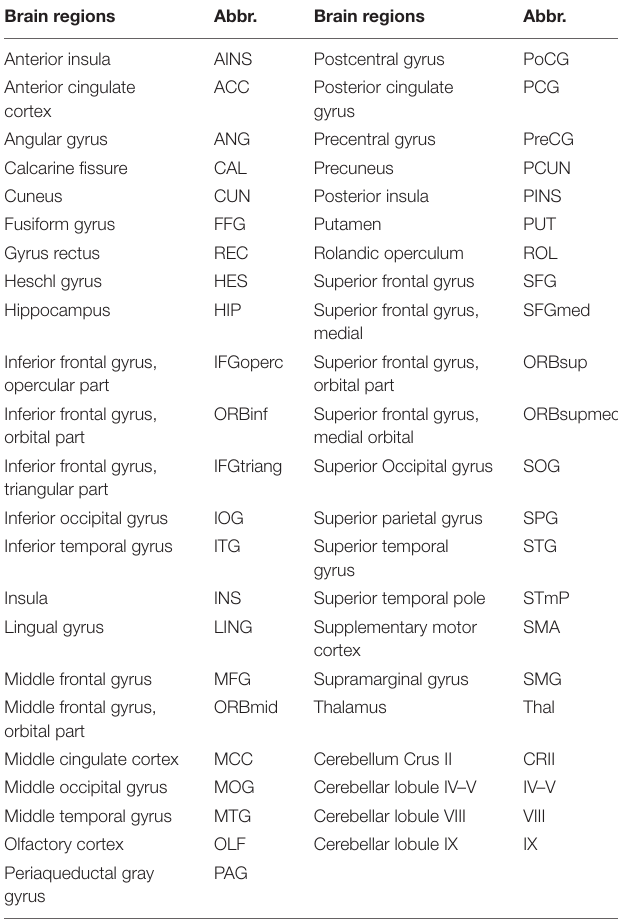
TABLE 8 | Abbreviations of brain